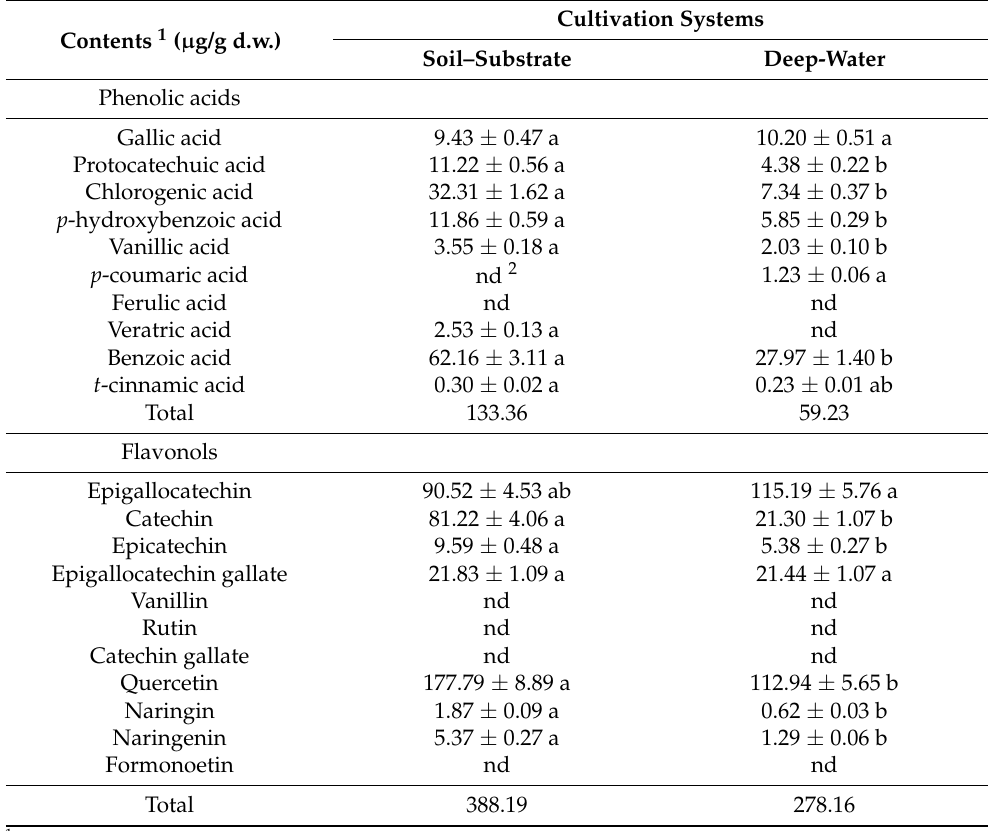
Table 4. Comparison of phenolic acid and flavonol contents of PGS in different cultivation systems in a plant